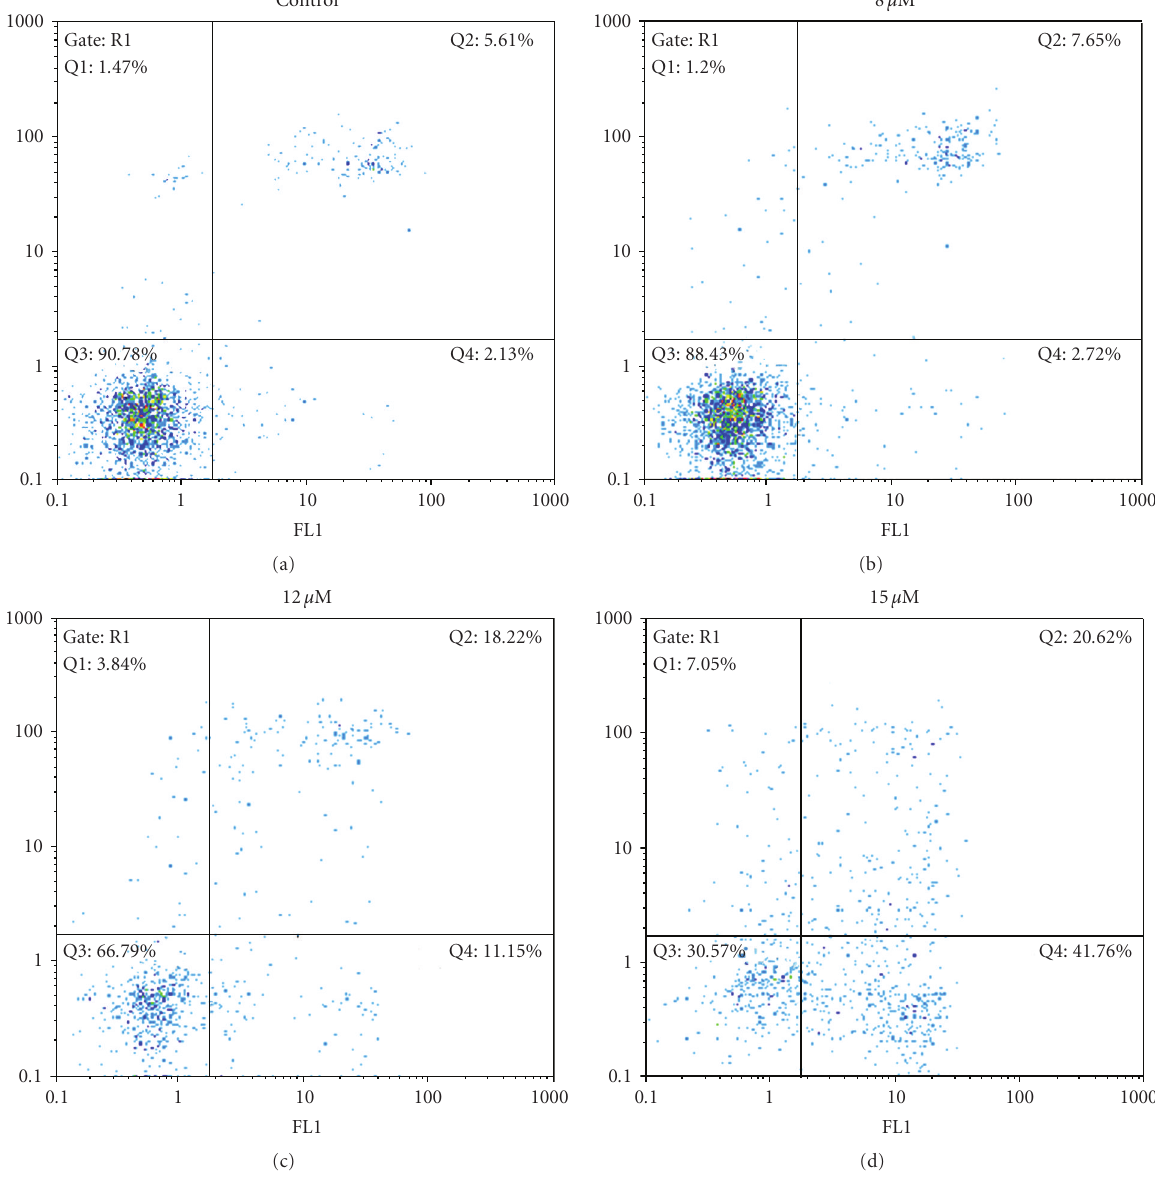
Figure 4: Flow cytometry assay summary results for LMS cells, treated with various concentrations of 1 (8, 12, and 15 μ M) for 48 hours of incubation, in comparison with the untreated cells